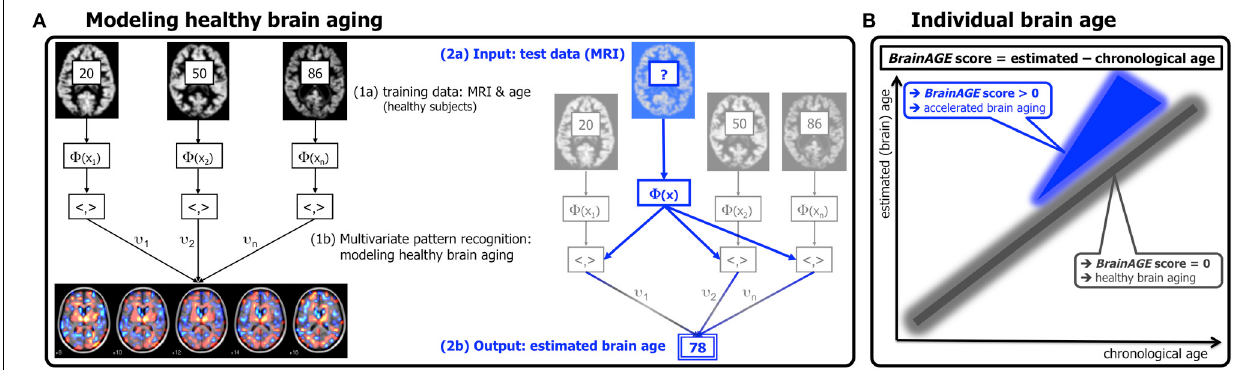
based on their MRI data (blue; picture modified from Schölkopf and Smola, 2002). (B) The difference between the estimated and chronological age results in the BrainAGE score, positive BrainAGE scores indicate accelerated brain aging. (Image reproduced from Franke et al. (2012a), with permission from Hogrefe Publishing,